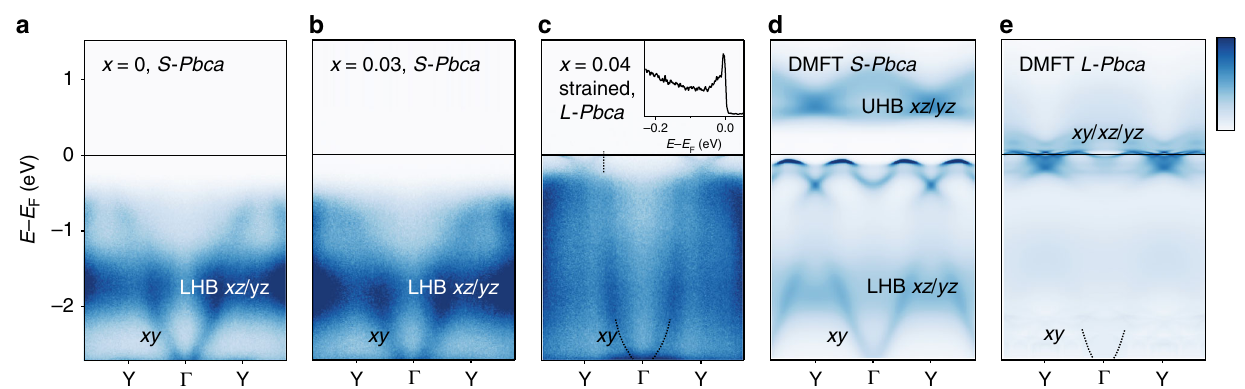
Fig. 4 Redistribution of spectral weight across the MIT. ARPES spectral weight along Γ Y measured for different dopings and structures: a undoped Ca 2 RuO 4 at 180 K ( S-Pbca , paramagnetic); b Ca 2 − x Pr x RuO 4 with x = 0.03 at 150 K ( S-Pbca , paramagnetic); c fully strained Ca 2 − x Pr x RuO 4 ( x = 0.04) at 10 K ( L-Pbca , metallic). We display a superposition of data acquired with left and right circular polarization; the inset in c shows a clear quasiparticle peak at k = k F (dotted line); d , e DMFT calculation for the S-Pbca and L-Pbca structure along the same cut. For details, see methods. The bottom of the xy band, which becomes visible upon enhancing the contrast in the DMFT calculation of the metallic state is indicated by a dotted line in c , e . Dark colors correspond to